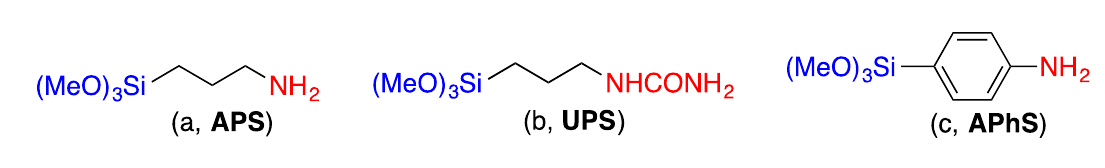
surface with: ( a ) 3-trimethoxysilyl-propan-1-amine 2